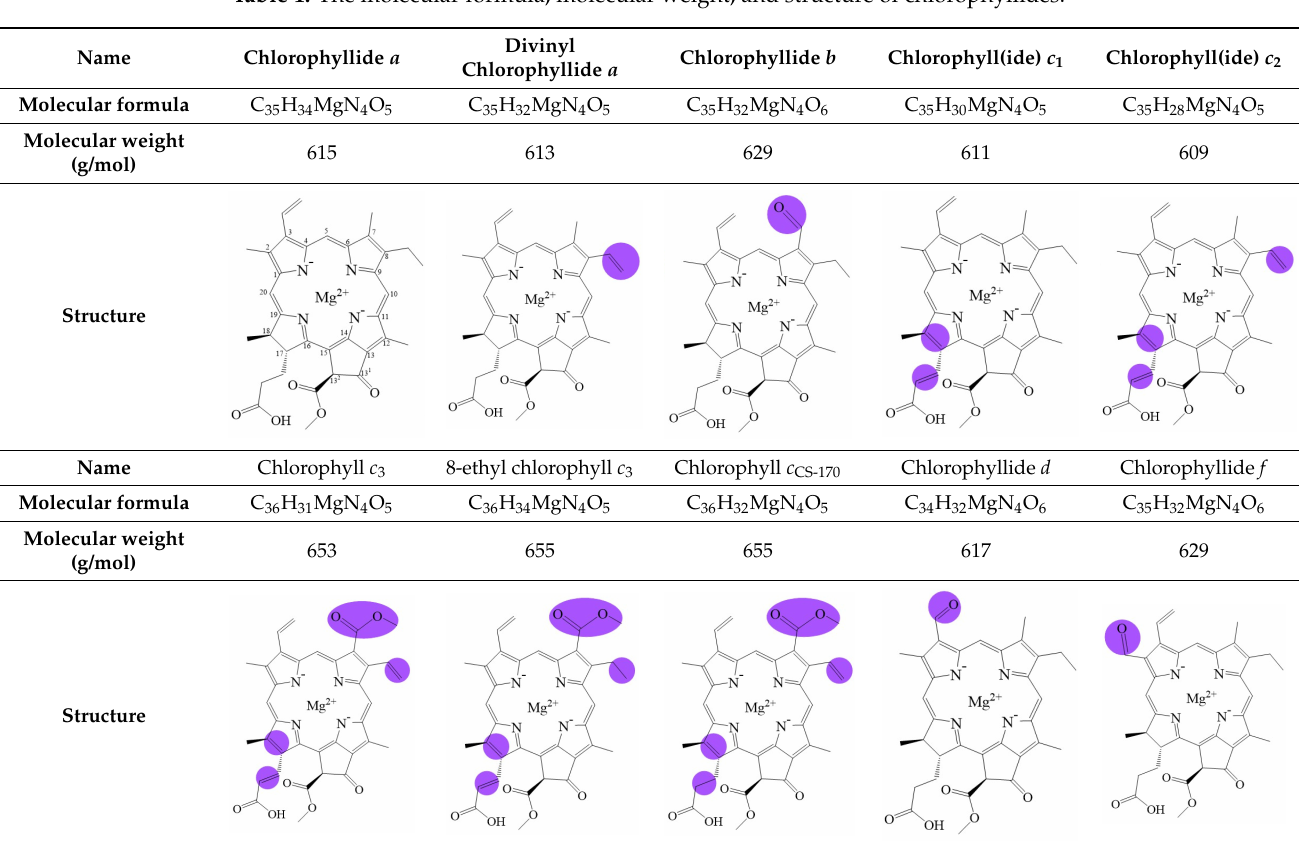
Table 1. The molecular formula, molecular weight, and structure of